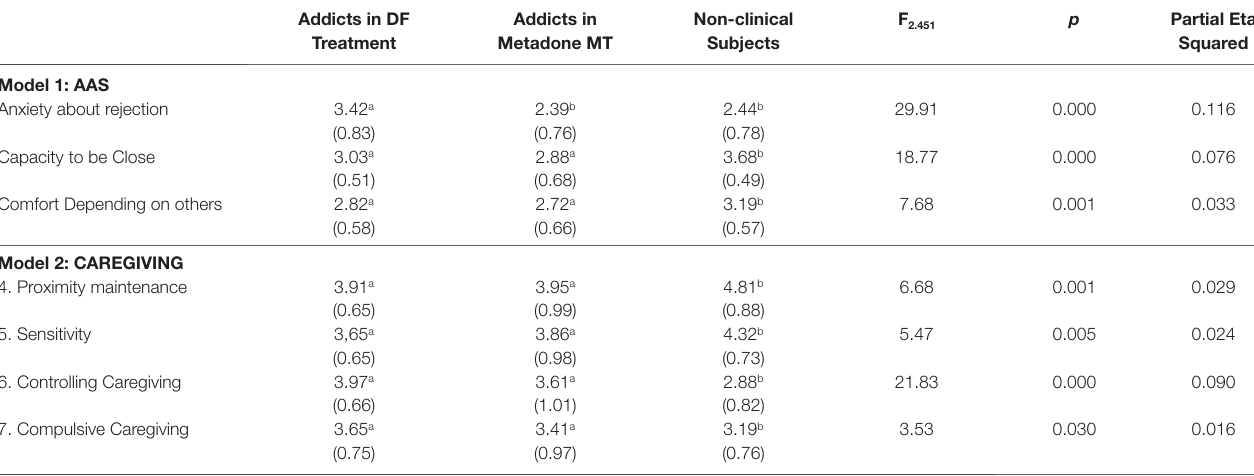
TABLE 2 | MANCOVA models’ results and differences between groups on Attachment and Caregiving variables. Addicts in DF